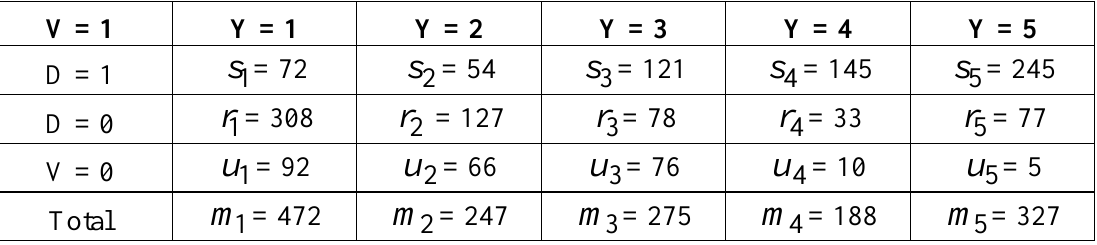
Table 16. Ordinal results for mammography.